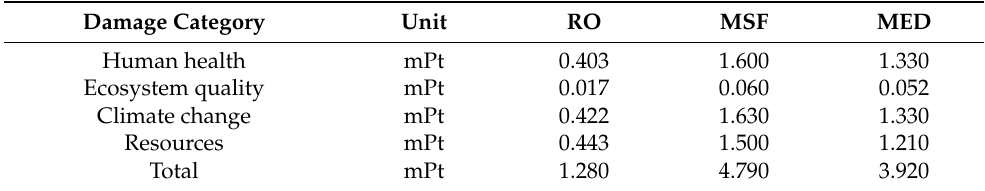
Table 14. Summary of impact assessment results, with the weighting as a single score, using